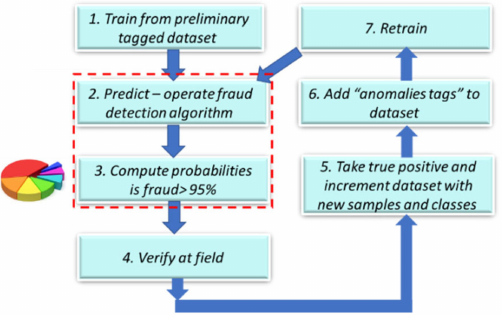
Figure 6. Iterative outer algorithm flow diagram. The dashed square marks the modules in Figure 1. The algorithm is an implementation of the feedback loop in Figure